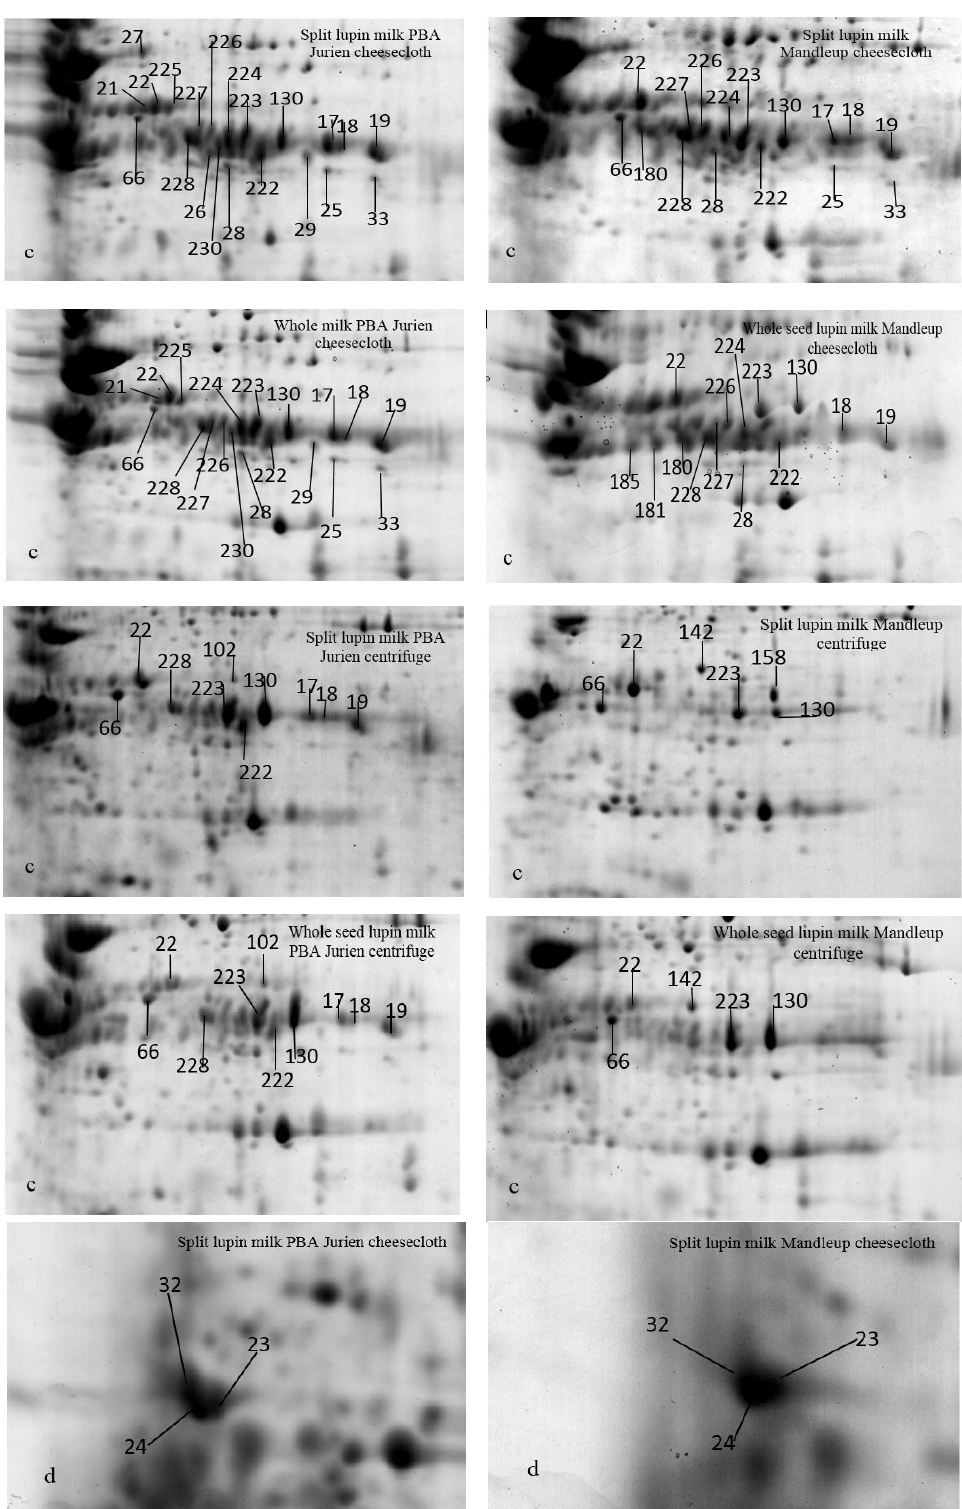
Figure 4. Comparison of cultivar-specific proteins of region c and d in Figure 2. Region c shows the split and whole seed lupin milk by specific separation method and region d shows the split lupin milk as influenced by cheesecloth separation of the two cultivars. There is no region d for the centrifuge separation